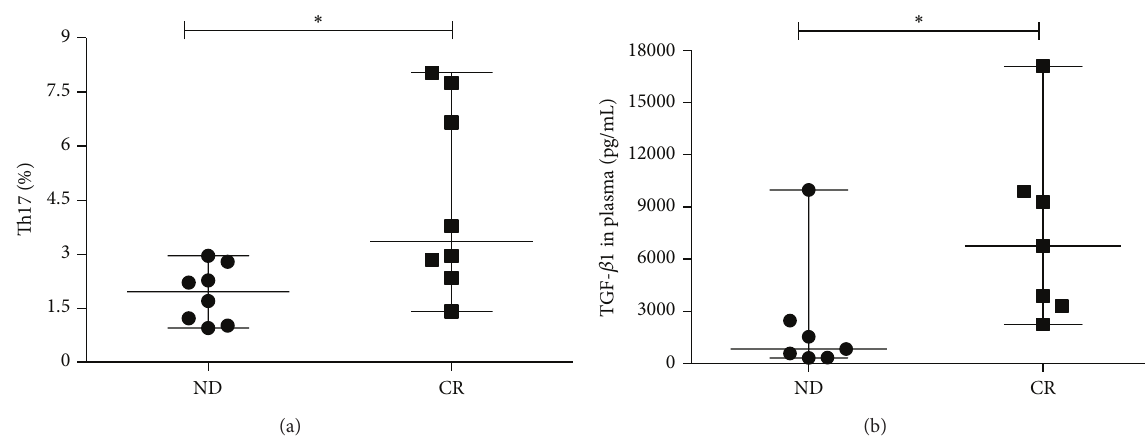
Figure 6: Th17 and associated cytokines in the same AML cohort. (a) Th17 percentage was observed significantly lower in ND stage than in CR stage of the same AML patients ( ∗ 𝑃 < 0.05 ). (b) A markedly lower TGF- 𝛽 1 concentration was observed in ND stage than in CR stage of the same AML patients ( ∗ 𝑃 < 0.05 ).